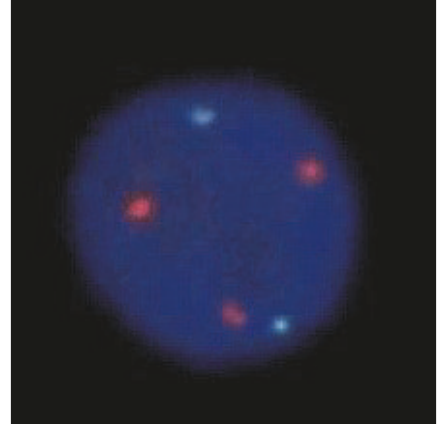
Figure 4: Fluorescence in situ hybridization image. Analysis for t(11;18)(q21;q21) translocation reveals no fusion genes of BIRC3 - MALT1 , although extra copies of MALT1 are identified, indicating trisomy of chromosome